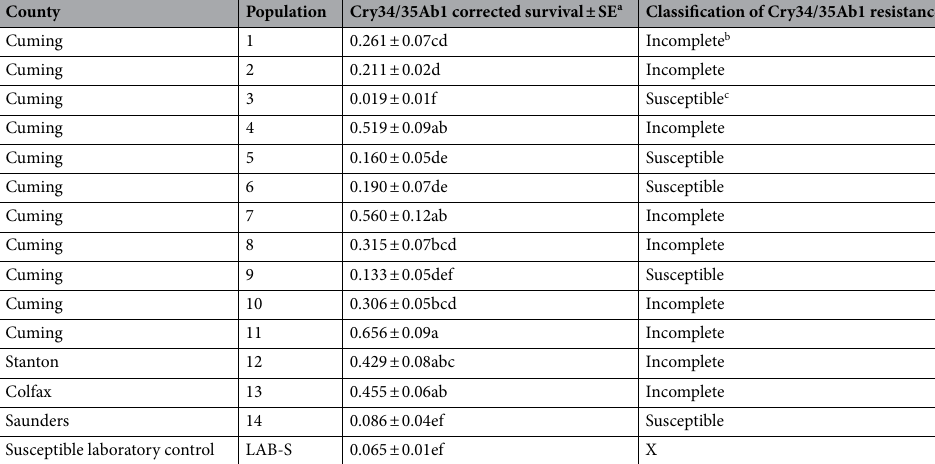
Table 1. Corrected survival (± SE) of western corn rootworm populations assayed on Cry34/35Ab1 maize during 2019. a Corrected survival values followed by the same lowercase are not significantly different ( p > 0.05); b incomplete resistance criteria: (1) significantly greater survival on Cry34/35Ab1 maize compared to the LAB-S control, and (2) within a population, proportional survival and/or larval development was significantly lower on Cry34/35Ab1 maize relative to non-RW Bt maize; c susceptible criteria: no difference in survival on Cry34/35Ab1 maize compared to the LAB-S